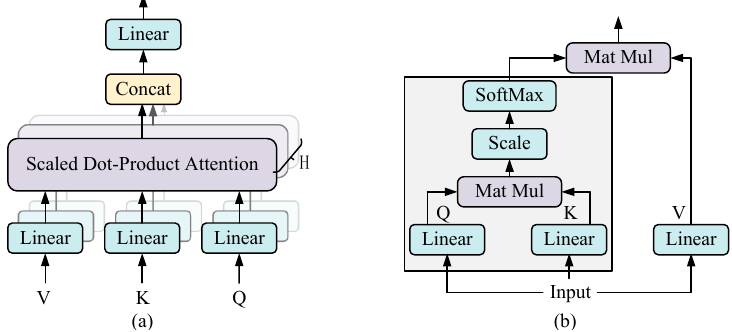
Figure 3. ( a ) Multihead self-attention module. ( b ) Scaled dot-product